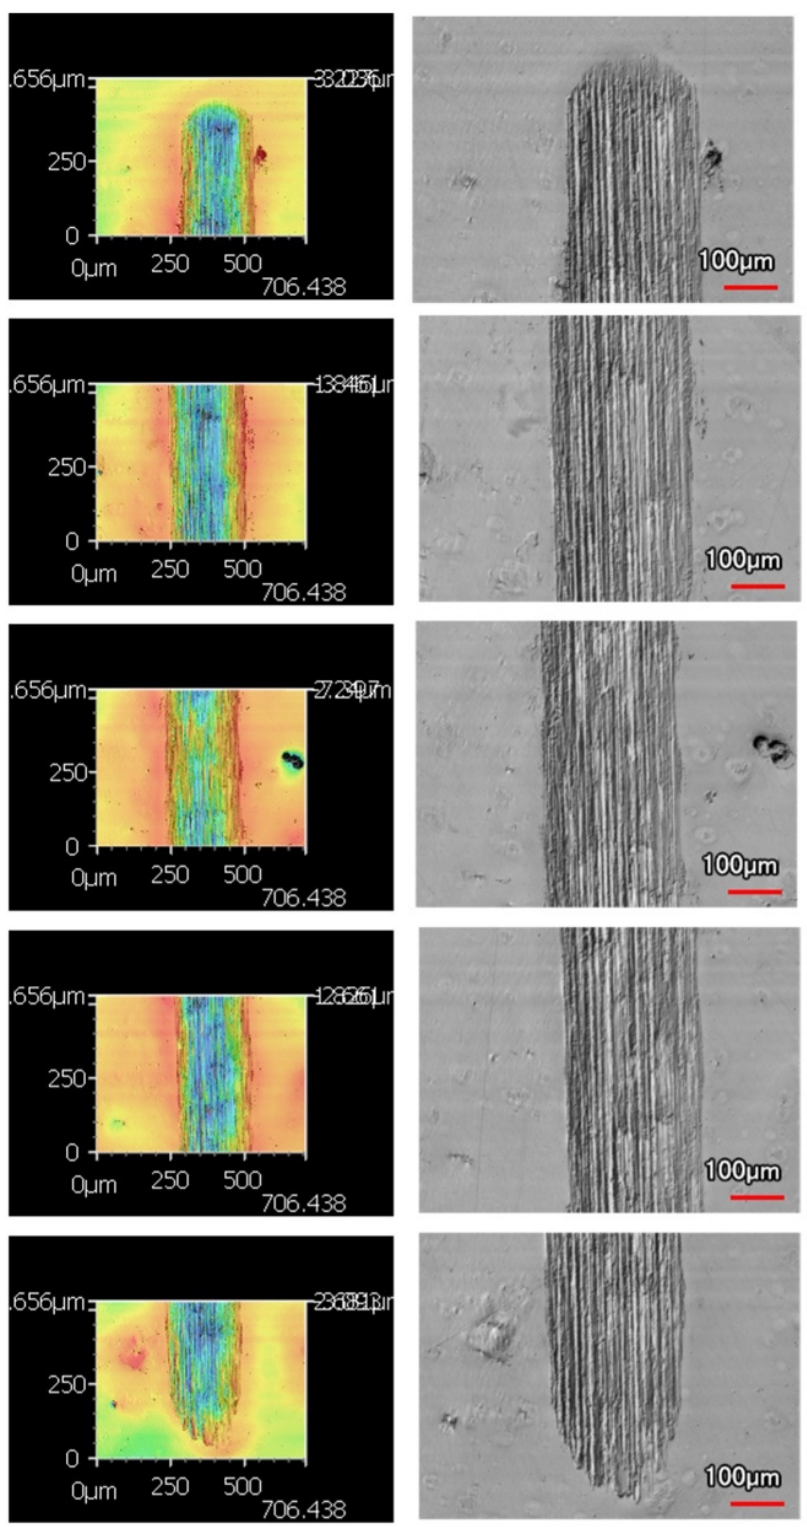
Figure 9. Micrographs of Wear Track from 50 Passes of the Spherical Indenter on 9 μ m Thick Ni-P Coating.